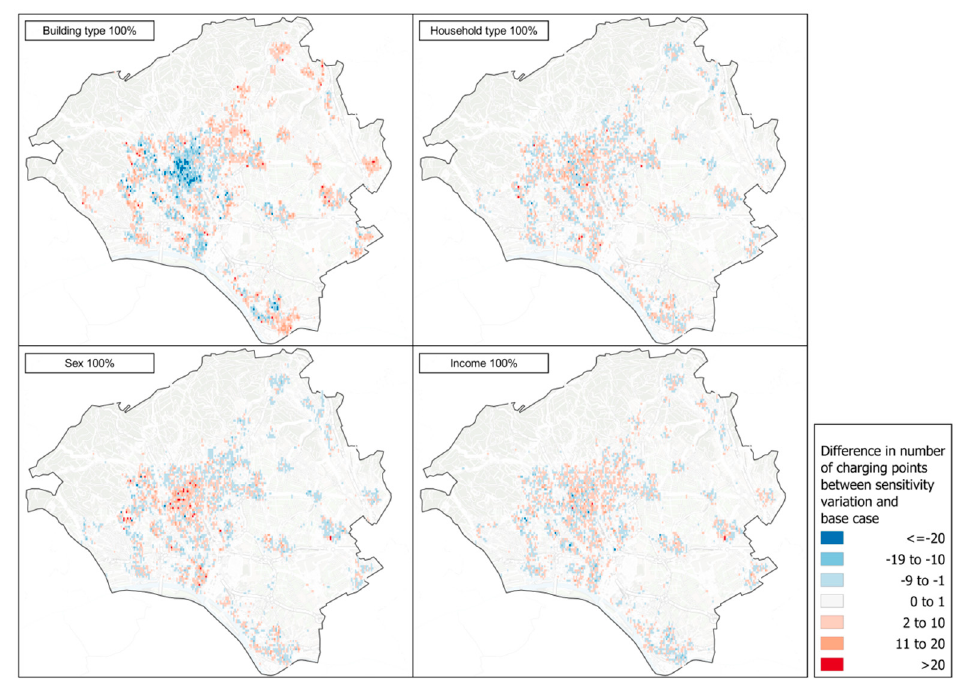
Figure A1. Di ff erences in spatial distribution of charging points between four sensitivity Figure A1 . Differences in spatial distribution of charging points between four sensitivity variations variations and the base case in Wiesbaden. Map data copyright OpenStreetMap contributors and the base case in Wiesbaden. Map data copyright OpenStreetMap contributors (www.openstreetmap.org / (www.openstreetmap.org/copyright).